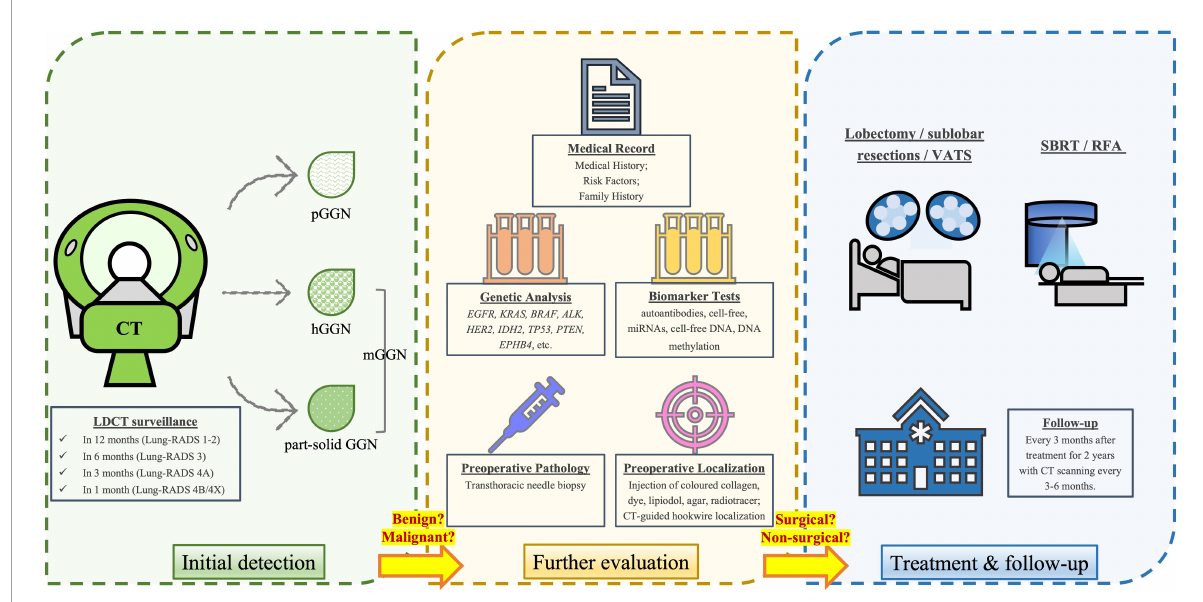
FIGURE1 Diagnostic, treatment and follow-up procedures for individuals with GGNs. After initial detection via LDCT scan, a repeat LDCT in 12 months is recommended for negative findings or benign appearance/behavior (Lung-RADS category 1-2), while a 6-month repeat of LDCT is recommended for those with probably benign nodules (Lung-RADS category 3). The suspicious nodules (Lung-RADS category 4A) and very suspicious nodules (Lung-RADS category 4B & 4X) should be more closely monitored in 3 and 1 month, respectively. A clinical comprehensive evaluation is required to determine whether the nodule is more likely benign or malignant, based on the type and size of the nodule, as well as medical record and laboratory tests (e.g., genetic and biomarker analysis). Prior to surgery, biopsy and preoperative localization is usually conducted. The standard surgical treatments include lobectomy or sublobar resections, while video-assisted thoracoscopic surgery (VATS) is a less-invasive surgical method. For those who are unfit or unwilling to receive surgical treatments, non-surgical treatments such as stereotactic body radiation therapy (SBRT) and radiofrequency ablation (RFA) may be the options. After treatment, physicians need to follow-up the patient every 3 months after treatment for 2 years, with CT repeated every 3–6